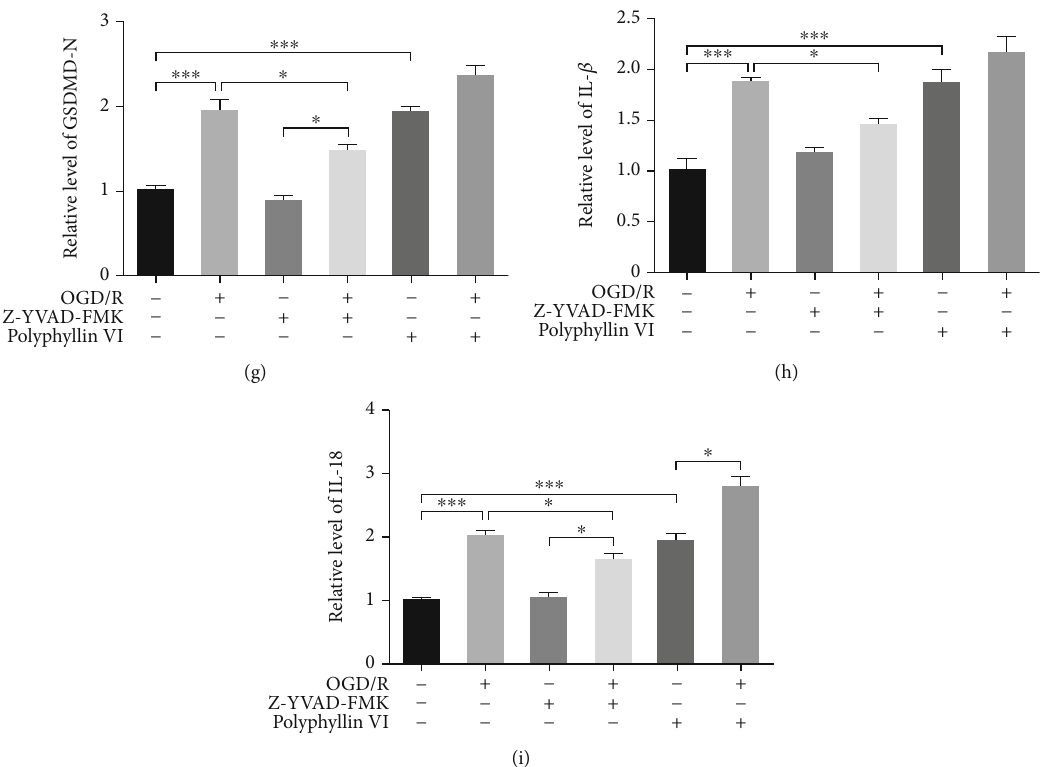
Figure 3: OGD/R decreased the cell viability and increased cytotoxicity, XBP-1 slicing, and in fl ammation in HT22 cells. The HT22 cells were, respectively, pretreated with Z-YVAD-FMK (20 μ M) and polyphyllin VI (4 μ M) 30min before exposing to OGD/R for 24h. (a) Cell viability was detected in HT22 cells using a CCK-8 assay. (b) LDH release was detected in HT22 cells using an LDH assay. (c) Representative western blots and quanti fi cation of the indicated proteins in the cellular lysate from HT22 cells in each group. Relative expression was normalized to that of the control group. (d – i) The expression of XBP-1s, NLRP3, Caspase-1, GSDMD-N, IL-1 β , and IL-18 in HT22 cells after OGD/R. Asterisks indicate statistical signi fi cance ( ∗ p < 0 : 05 , ∗∗ p < 0 : 01 , ∗∗∗ p < 0 : 001 ). All experiments were repeated for three